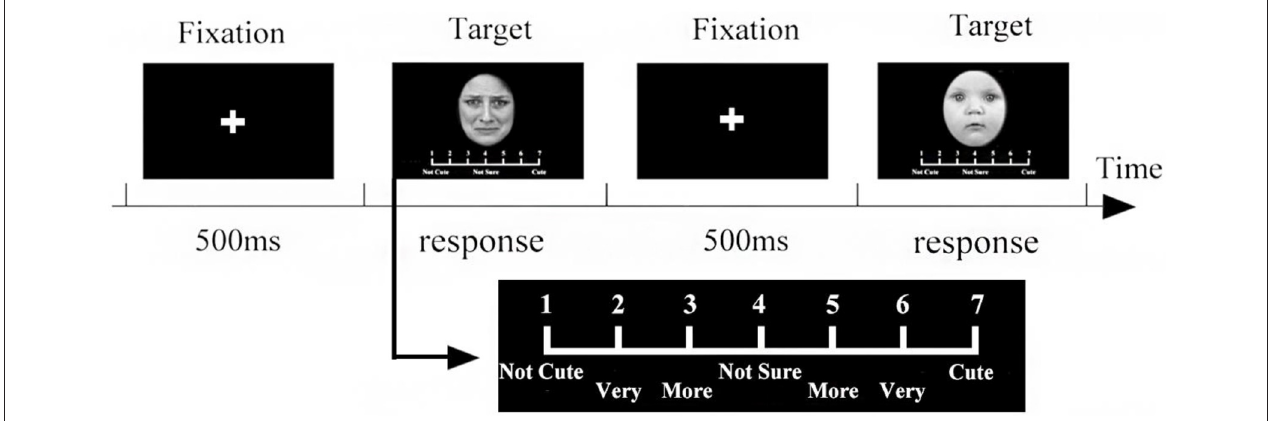
FIGURE 5 | The 7-point scale procedure. After the fixation point was presented for 500ms in the center of the screen, the stimuli were presented in a random order, and the evaluation scale was displayed under each stimulus. The participants were asked to evaluate the cuteness of each stimulus on a 7-point scale. After participants reached, the next fixed point was displayed in the center of the screen.